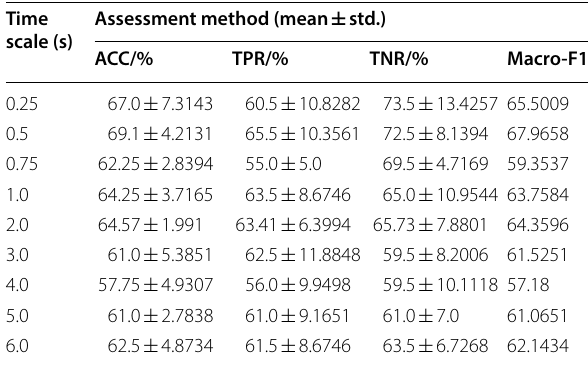
Table 6 The classification results of RT‑ERM with different time scales for α rhythm under the dimension of emotion arousal Time Assessment method (mean scale (s)